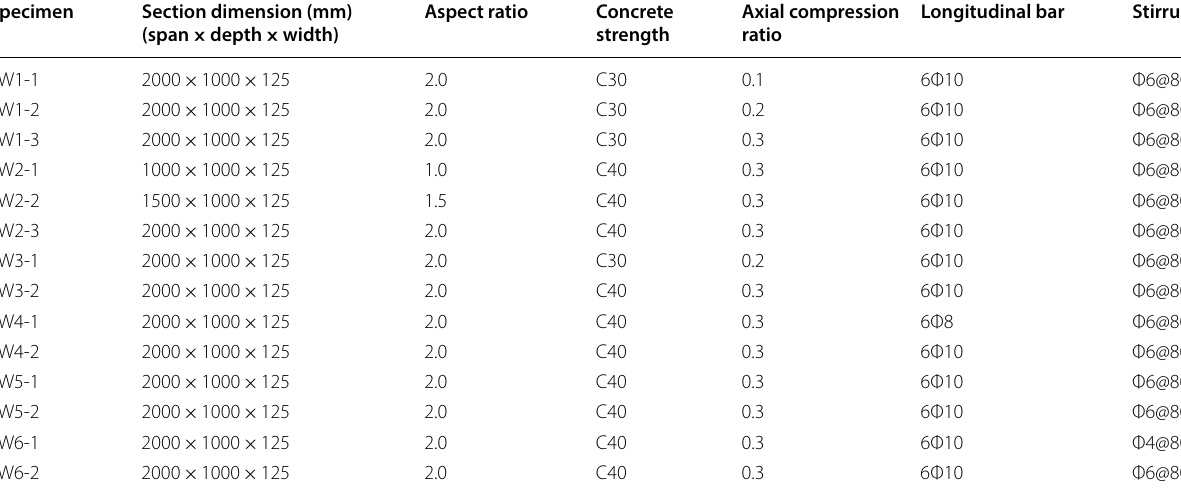
Table 4 Details parameter of